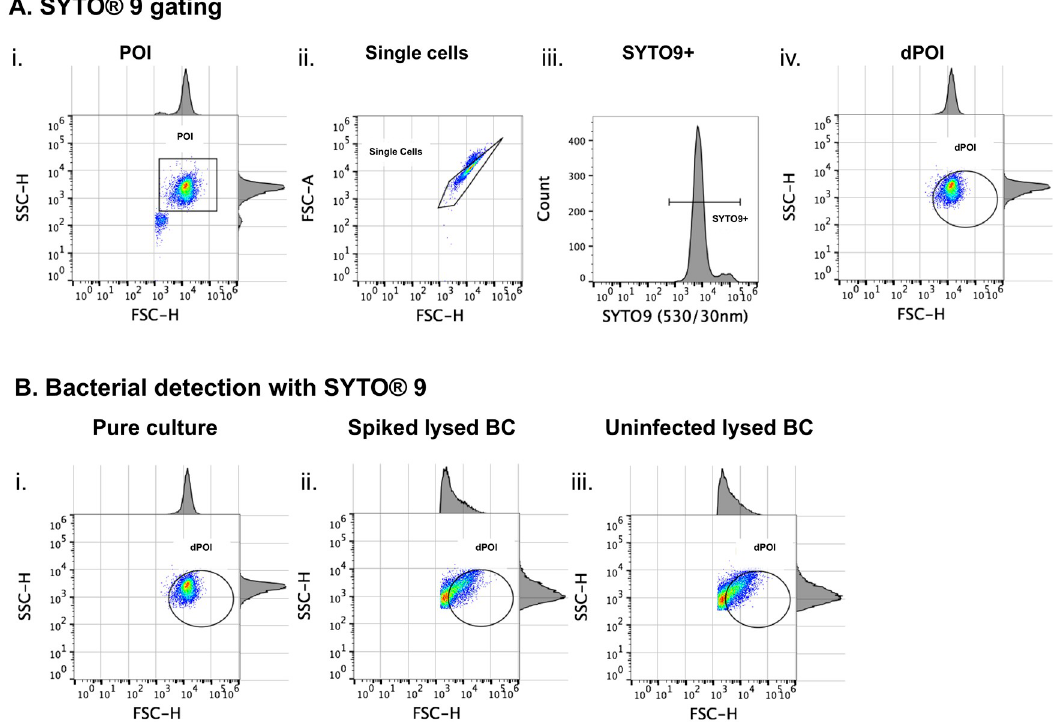
Fig 2. Bacterial detection by acoustic flow cytometry after direct staining with SYTO 9 in pure bacterial culture and inoculated blood culture. A : SYTO 9 gating for bacteria grown in TSB as pure culture: the population of interest (POI) was gated based on the FSC-H/SSC-H scatter plot (i) while single bacterial cell events were identified in the FSC-H/FSC-A plot (ii). Events that were SYTO 9 positive were gated in the BL1-H channel (iii) and back-gated to FSC-H/SSC-H scatter plot to identify bacterial cells labelled with SYTO 9, denoted as derived POI (dPOI) (iv) since SYTO 9 binds to other particles containing nucleic acids. B : Bacterial detection in pure culture (i) and blood culture (ii) by SYTO 9 staining. Uninfected BC was used as a negative control (iii). Both pure culture (i) and blood culture (ii) were inoculated with identical concentrations of bacteria at approximately 8.00 x 10 4 CFU/mL. The pure bacterial culture was stained directly with SYTO 9, while both spiked and uninfected blood cultures were lysed with 10% Triton X- 100 before SYTO 9 staining. Note the strong background noise produced during the BC lysis in both infected and uninfected BC samples overshadowing dPOI (ii and